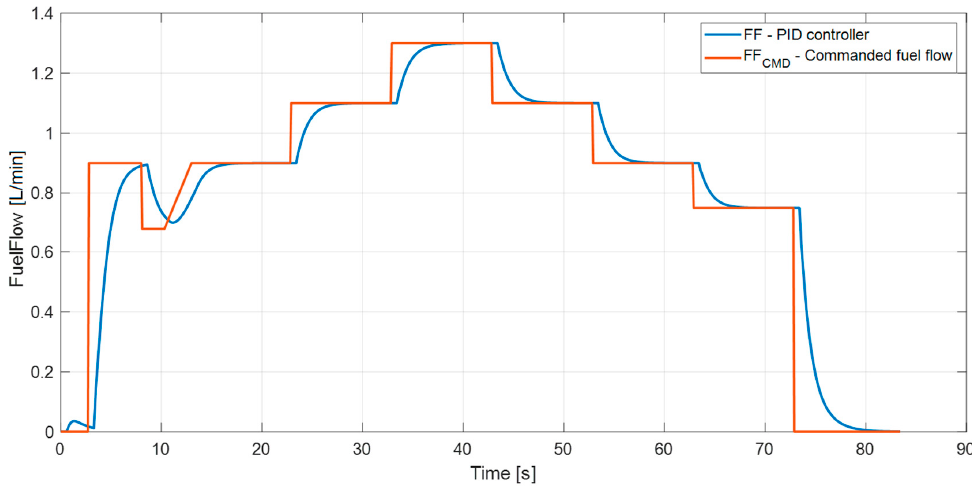
Figure 9. PID control—dynamic simulation.